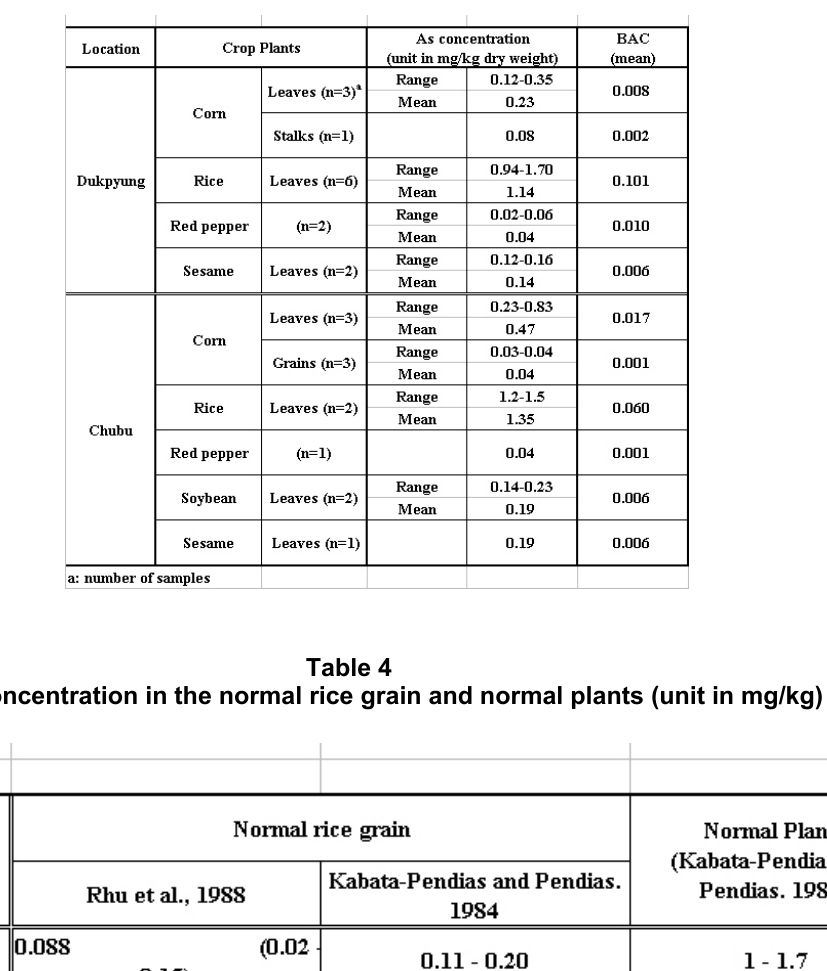
Concentrations of As and BAC values of the crop plants from the study